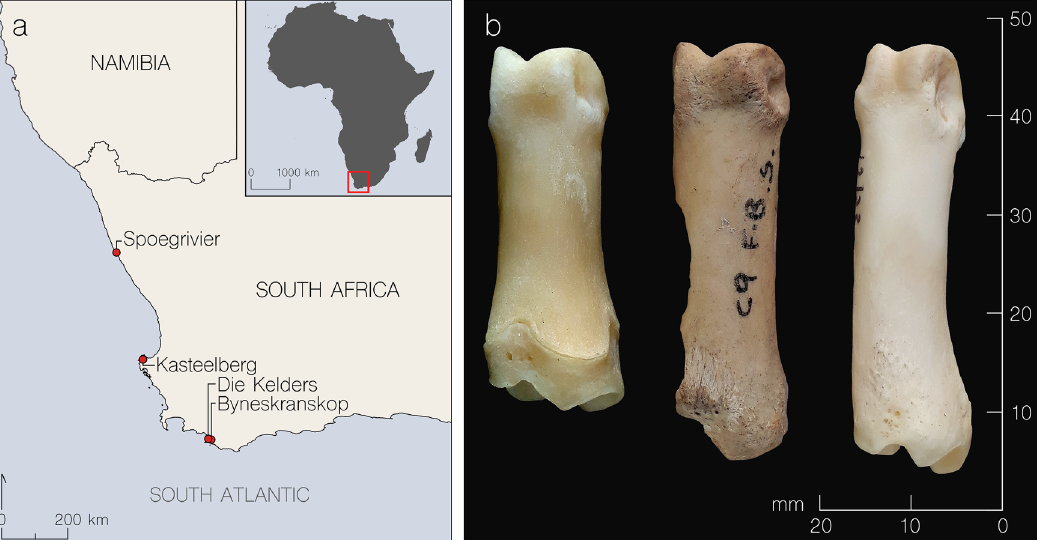
Figure 1. Location of archaeological sites and image of oldest sample investigated (P4859C) ( a ) Map showing locations of archaeological sites that yielded specimens analysed in this study. ( b ) First phalanx from Spoegrivier dated to 2105 ± 65 BP (centre) compared with modern sheep (left) and springbok